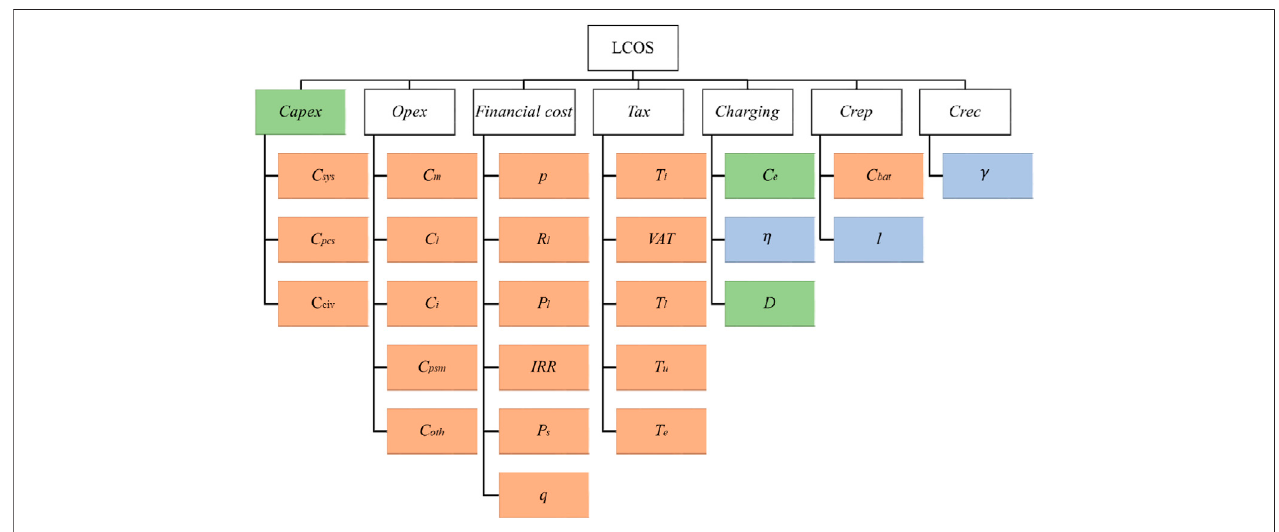
FIGURE 7 | Composition of the LCOS and data